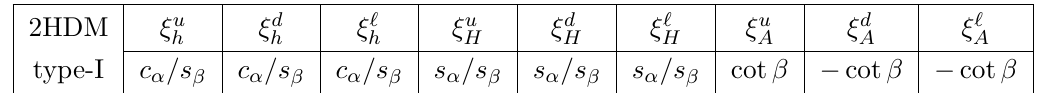
) as cos( β − α ) − sin( β /s α β